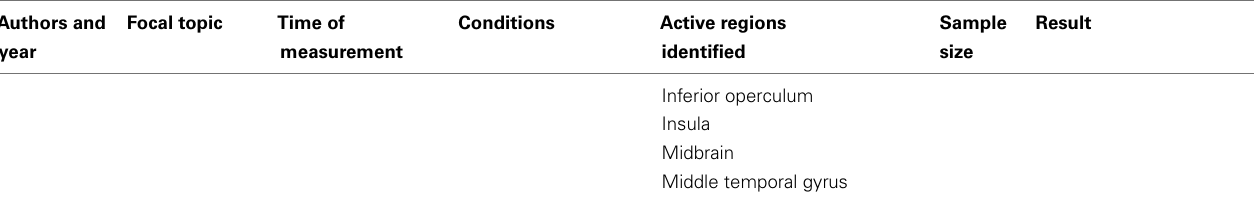
table is sorted first in chronological order, then in alphabetical